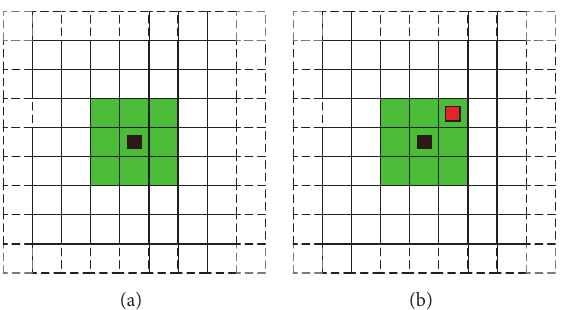
Figure 1: A representation of a vision radius, common in video games. The dark brown square represents our avatar, the red square the mobile agent, and the green tiles the positions we